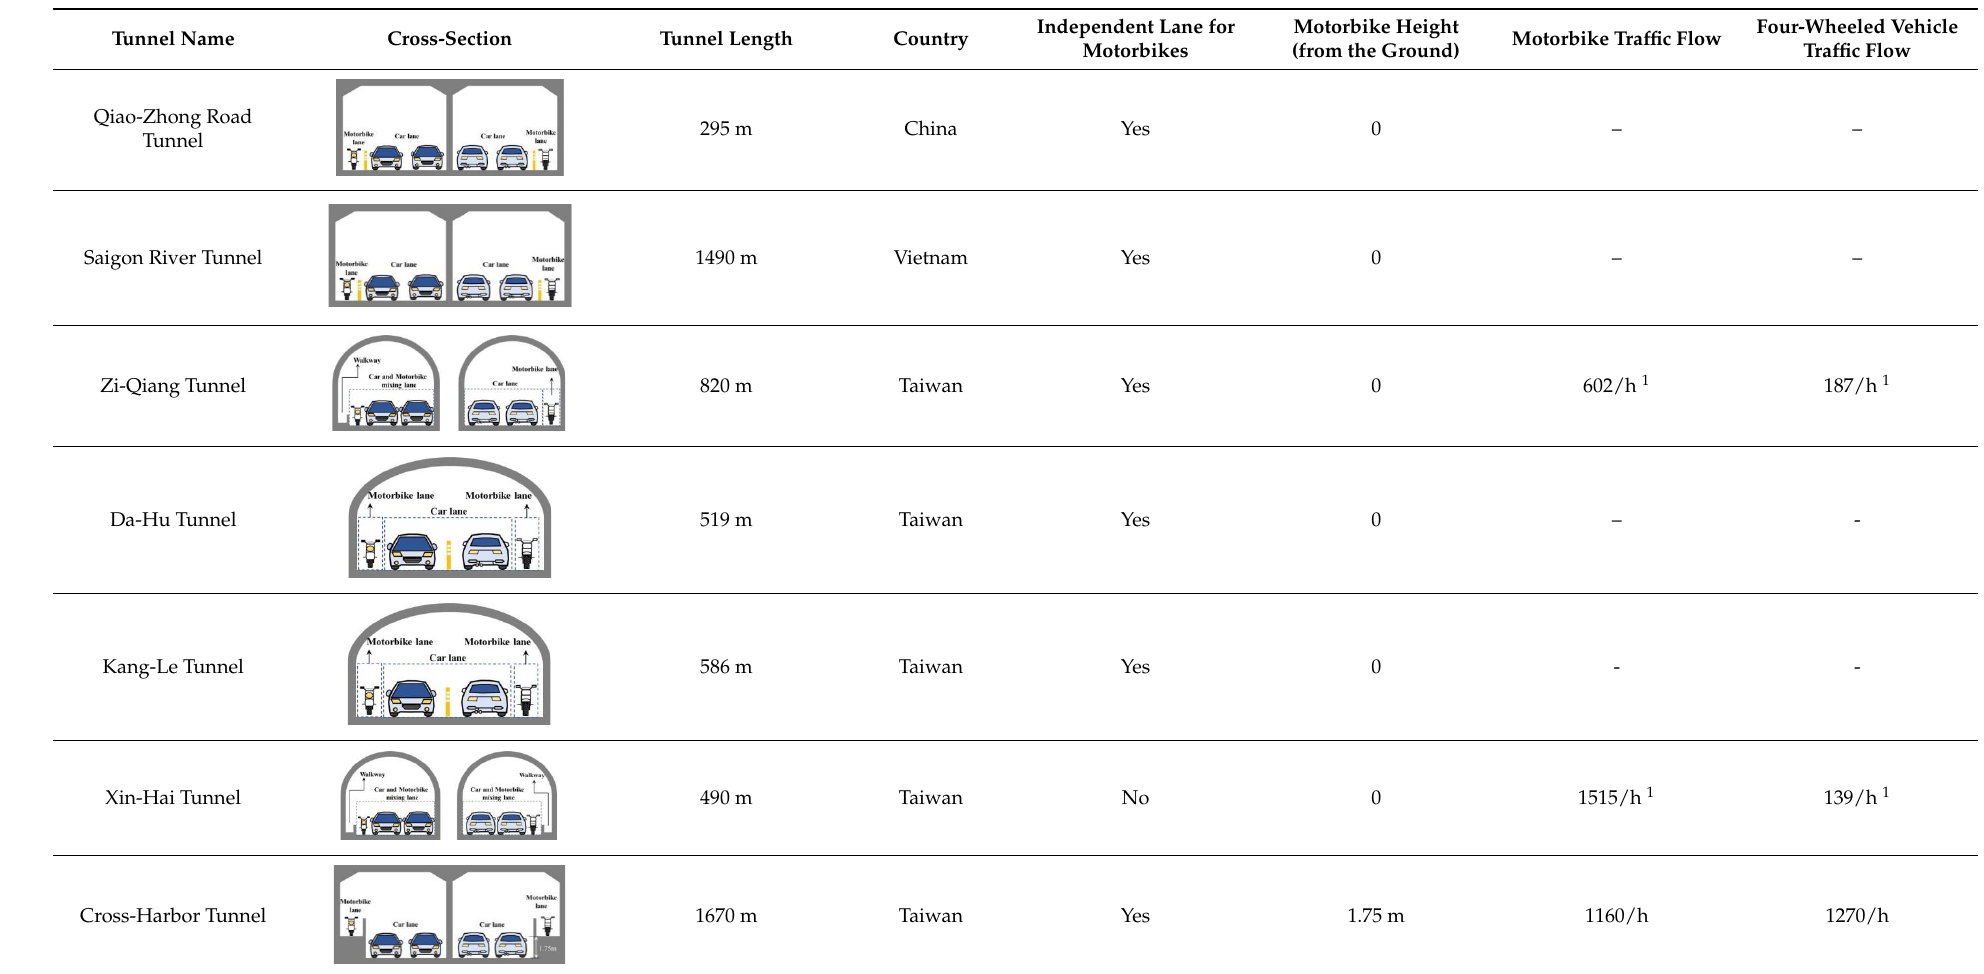
Table 1. Road tunnels that allow motorbikes.